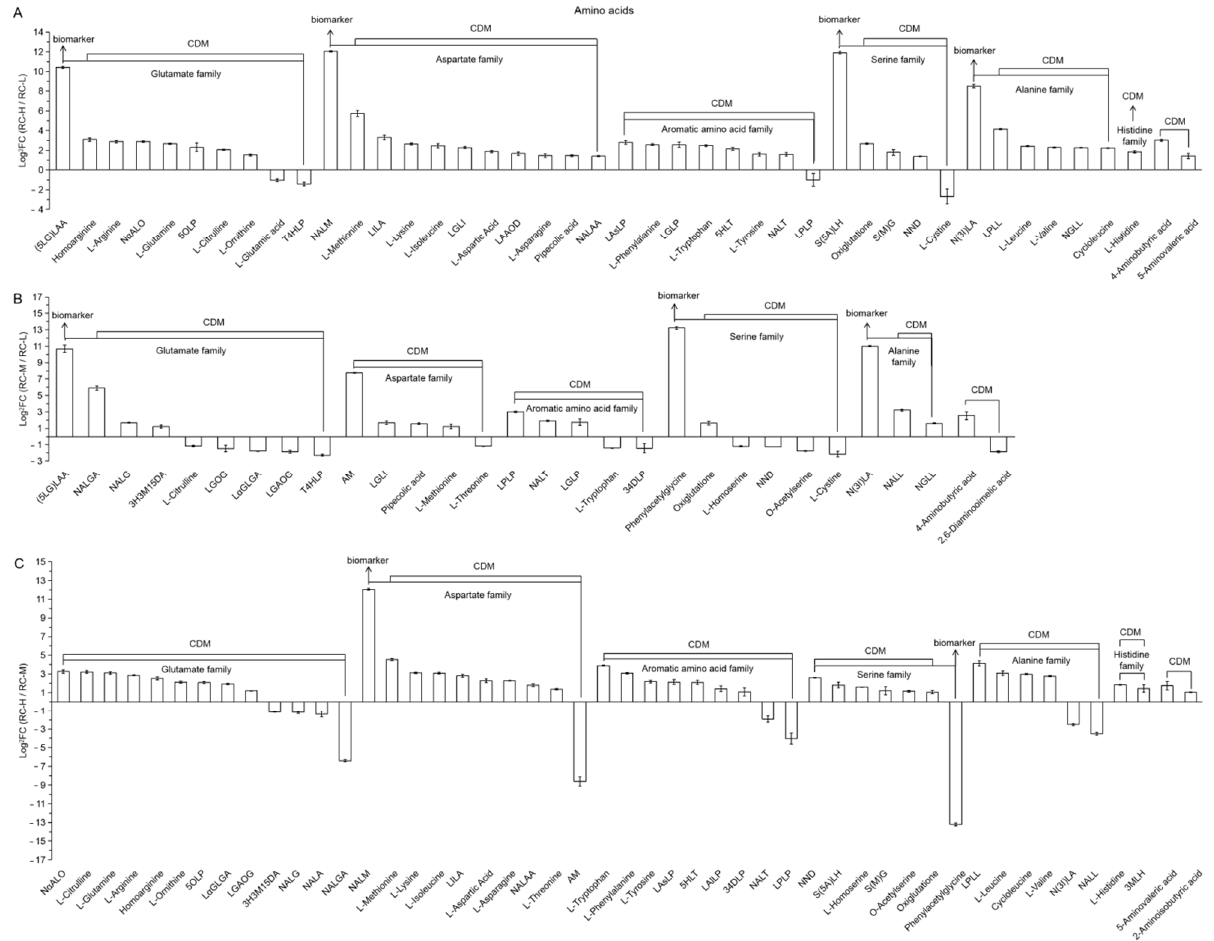
Figure 16. Comparison of differential metabolites of amino acids between RC-L, RC-M and RC-H. These were 4 biomarkers and 39 CDMs for RC-H vs. RC-L ( A ), 3 biomarkers and 27 CDMs for RC-M vs. RC-L ( B ), and 2 biomarkers and 47 CDMs for RC-H vs. RC-M ( C ). Upregulation denotes that the content of a metabolite in RC increased with elevation between two altitudes, and the opposite for downregulation. The Y-axis is shown as Log 2 FC values for the convenience of visual presentation (Note: The up-amplitude in the text refers to the FC value). The X-axis denotes metabolite names.